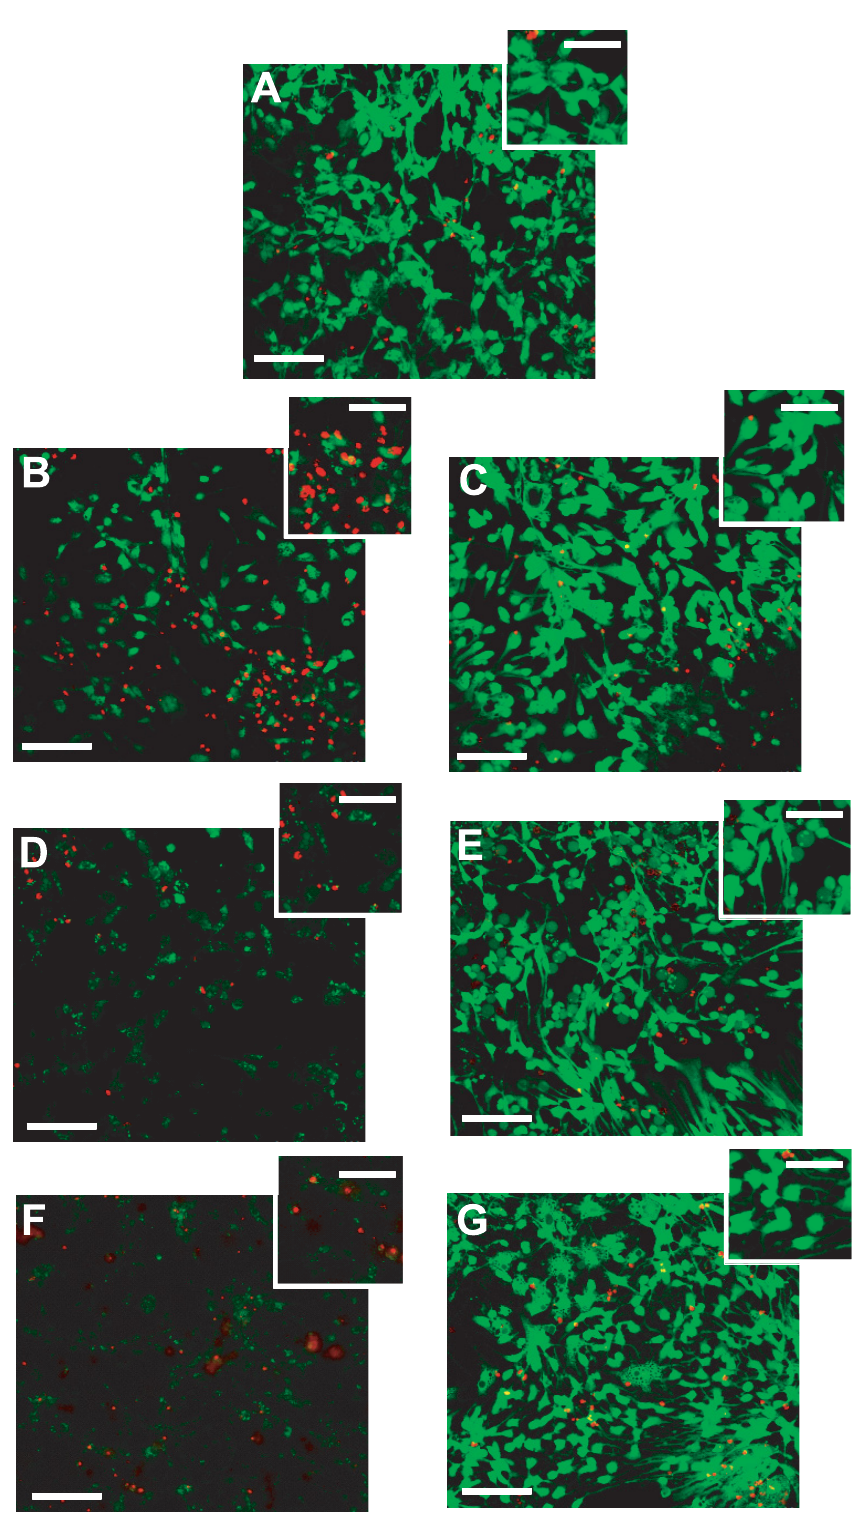
Fig 3. Pre-treatment with midi-GAGR significantly reduces the apoptosis of rodent cortical neurons caused by 4HNE, H 2 O 2 , and amyloid β peptide. (A-G) Mouse cortical neurons at DIV5 were